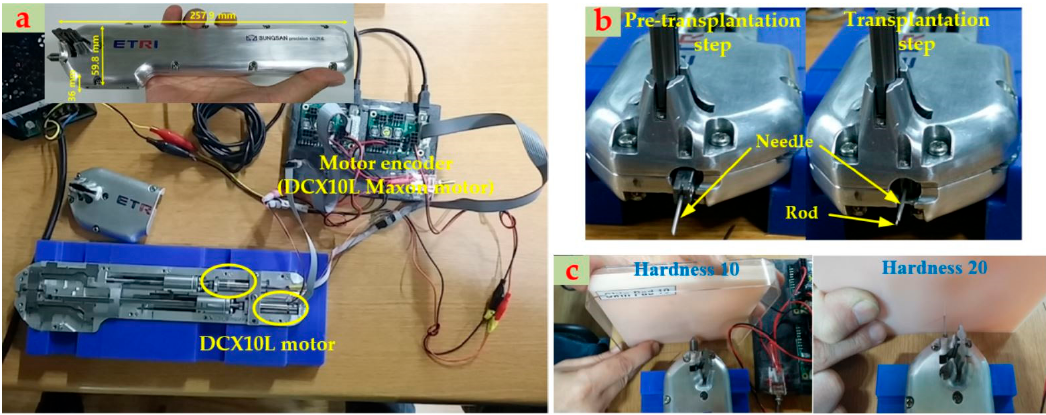
Figure 11. Driving environment for semi-automatic implanter. ( a ) Driving environment, ( b ) state of needle and rod at transplant, and ( c ) transplantation ability test.